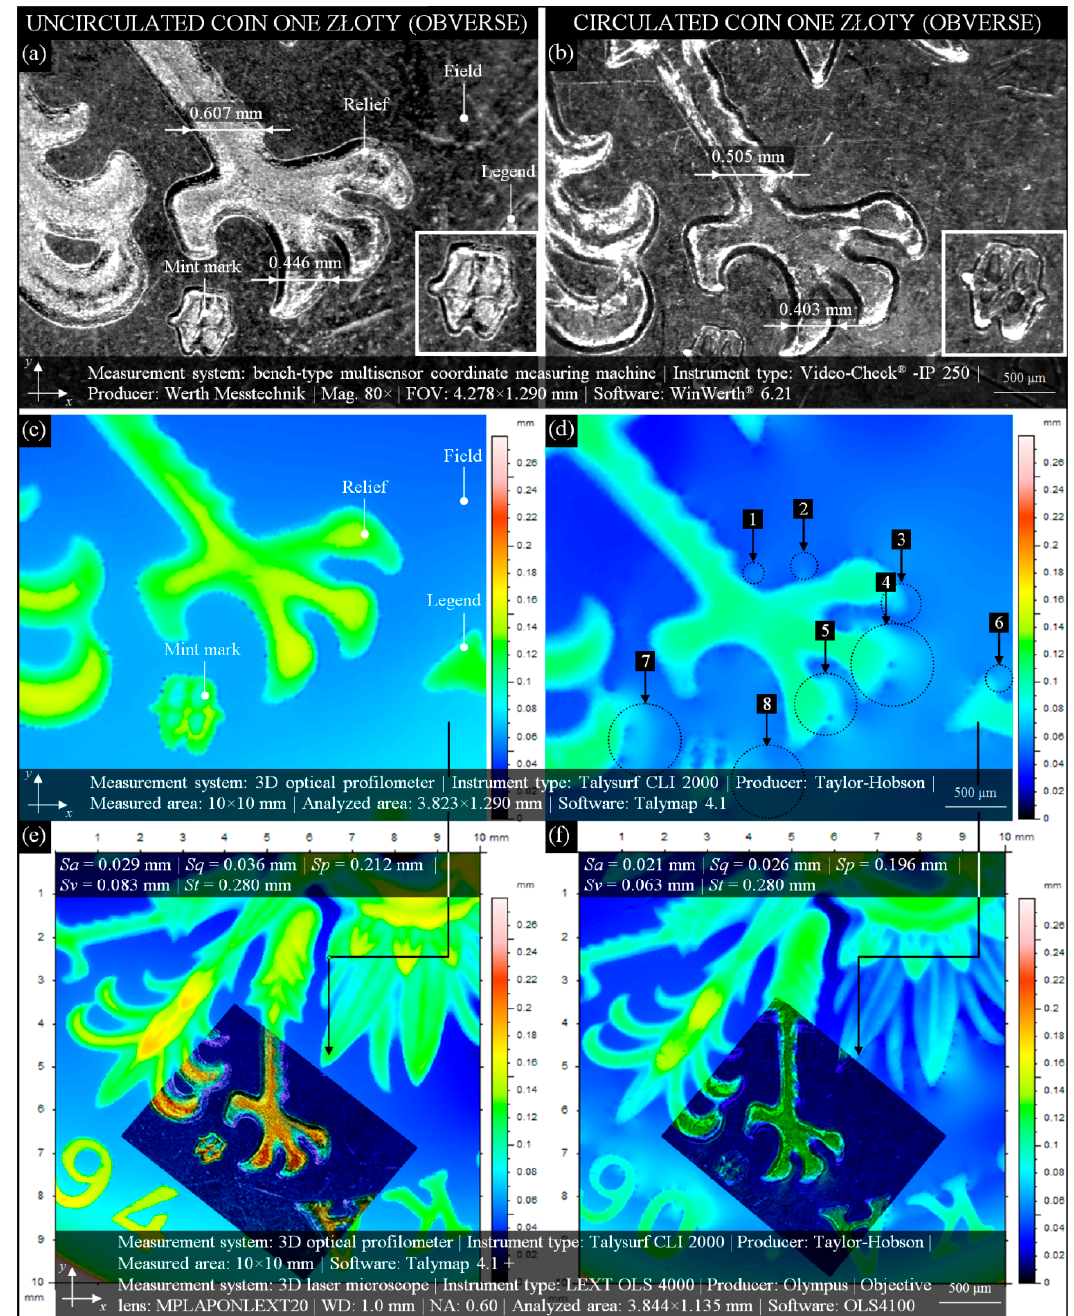
Figure 3. Selected results of observation and analysis of the surface condition of modern Polish uncirculated and circulated 1 z ł oty coin: images of the obverse of ( a ) uncirculated and ( b ) circulated 1 z ł oty coin issued in 1994 and 1990, respectively, acquired by bench-type multisensory coordinate measuring machine VideoCheck ® IP 250 (Werth Messtechnik, Gießen, Germany) with characteristic elements and dimensions corresponding to images from Figure 1a,b, the 2D height map (indexed colors) obtained by the 3D optical profilometer Talysurf CLI 2000 (Taylor-Hobson, Leicester, Great Britain) for the obverse of ( c ) uncirculated and ( d ) circulated 1 z ł oty coin with the visible worn surface of the field as well as relief, mint mark, and legend; image fusion of a vast fragment (10 × 10 mm) of ( e ) uncirculated and ( f ) circulated coin presented in the form of a 2D height map (indexed colors) with a fragment (3.844 × 1.135 mm) obtained by the 3D laser microscope LEXT OLS4000 (Olympus Corp., Shinjuku, Tokyo, Japan) in the form of a 2D pseudo-color height map.